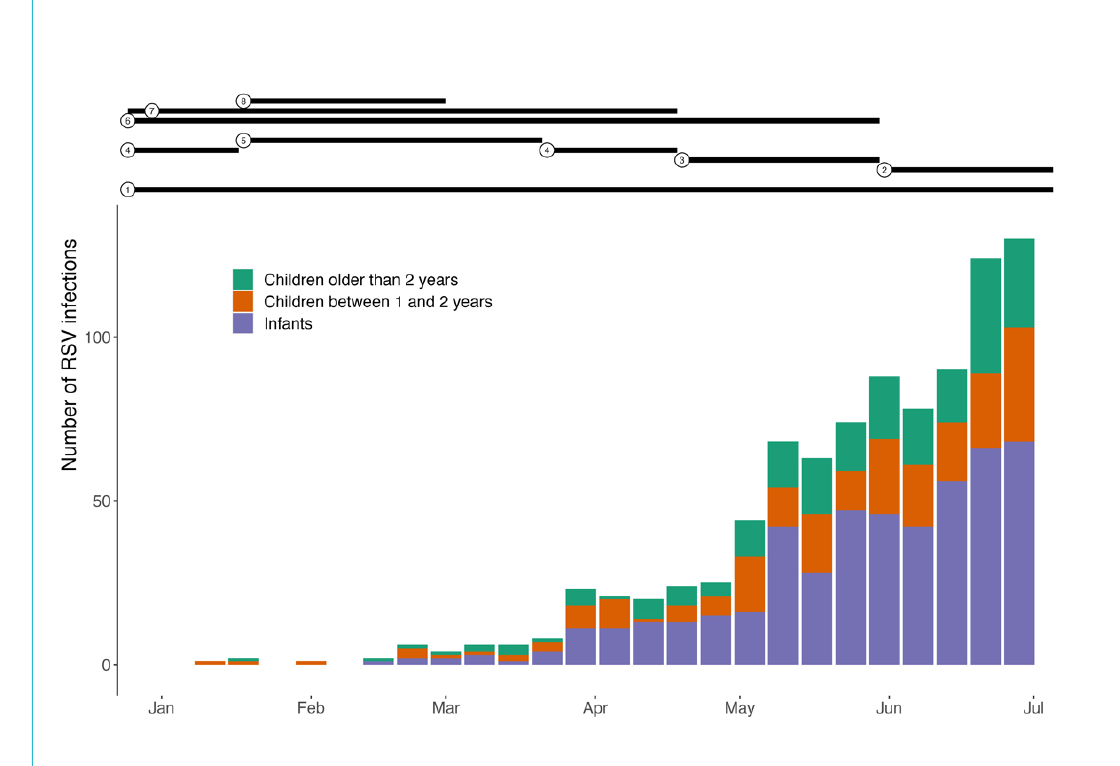
Figure 2: Weekly number of RSV infections in children in Swiss hospitals from 1 January to 4 July 2021, stratified by patient age. The black horizontal bars on top of the plot indicate the main non-pharmaceutical interventions in Switzerland, with increasing bar height indicating stronger restrictions: General recommendations 1. Public hygiene and social distancing >1.5 m (since 2 March 2020). Mandatory face masks in public transport for persons older than 10–12 years old (depending on region, since 6 July 2020) and in publicly accessible indoor venues (since 19 October 2020). Restrictions on private life; maximum number of people allowed to meet privately indoors 2. 30 persons (since 31 May 2021) 3. 15 persons (19 Apr to 30 May 2021) 4. 10 persons (29 Oct 2020 to 17 Jan 2021; 22 Mar to 18 Apr 2021) 5. 5 persons (18 Jan